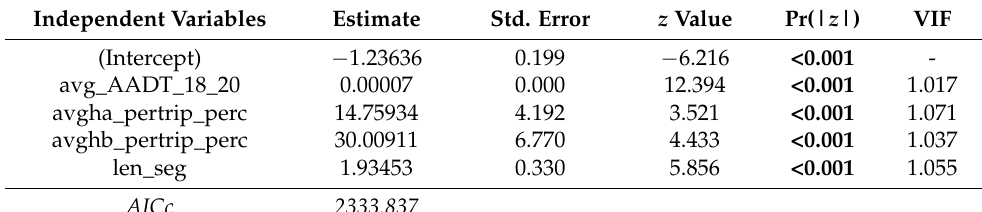
Table 2. Statistical model for crash frequency in motorway